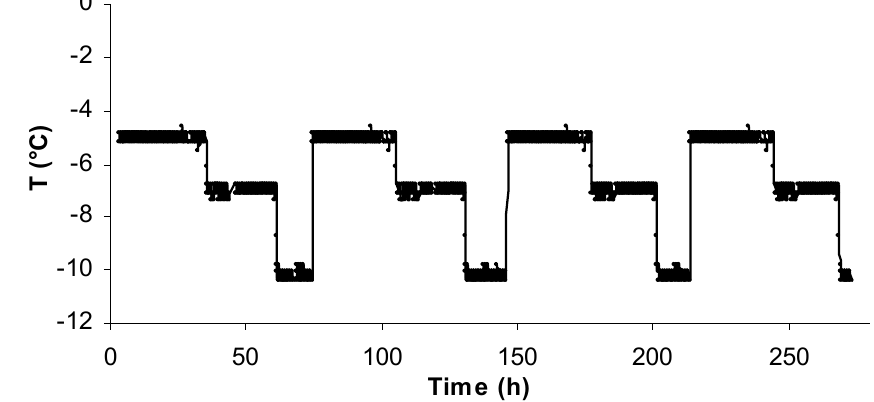
Figure 2. Temperature profile of the non-isothermal experiment.